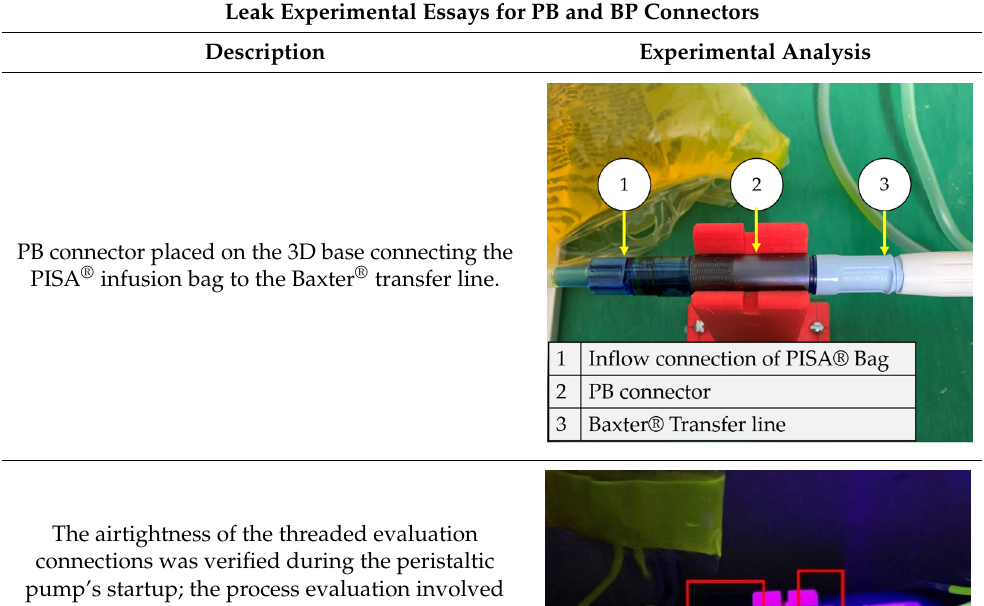
Table 9. Configuration of the experimental bench between the developed connectors and the com- mercial devices.